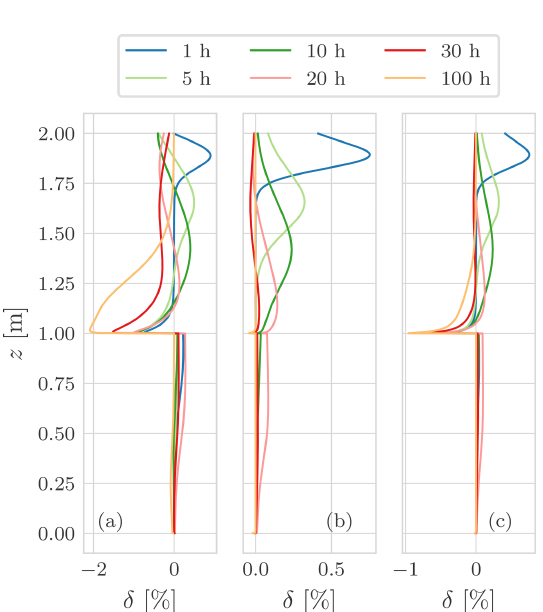
Figure C3. Comparison between the analytical and numerical solu- tions for the test problem TP2. Figure C4. Comparison of relative water suction error δ for the test problem TP2 using different interface hydraulic conductivity algo- rithms. (a) Computed with max, (b) with harmonic mean, and (c) with geometric mean. As reported in Romano et al. (1998), the har- monic mean offers the best agreement with the analytical